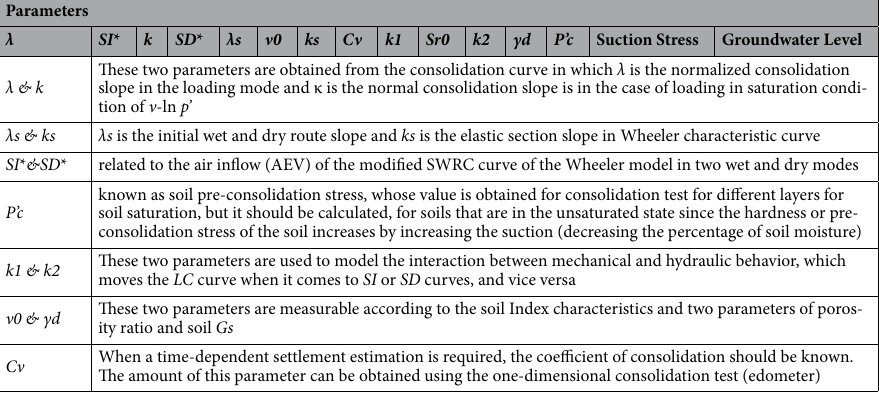
Table 3. The required parameters for the numerical modeling.